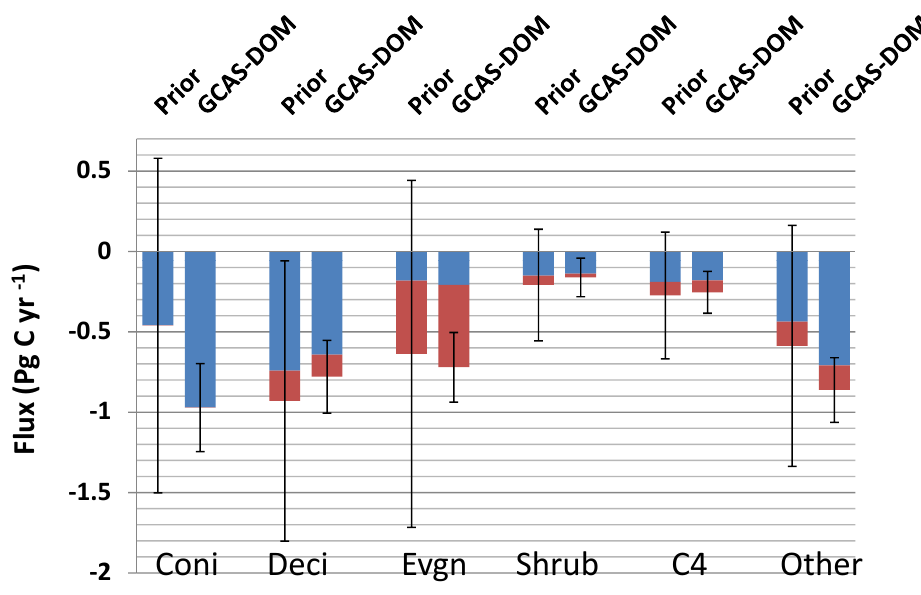
Figure 7. Annual mean flux per PFT and its uncertainty for the period 2001–2007. Coni stands for coniferous forest, Deci for deciduous forest, Evgn for evergreen forest, Shrub for shrubland, C4 for C4 vegetation and Other for other vegetation. Prior and GCAS-DOM are the fluxes before and after optimization. All units are in PgCyr − 1 .